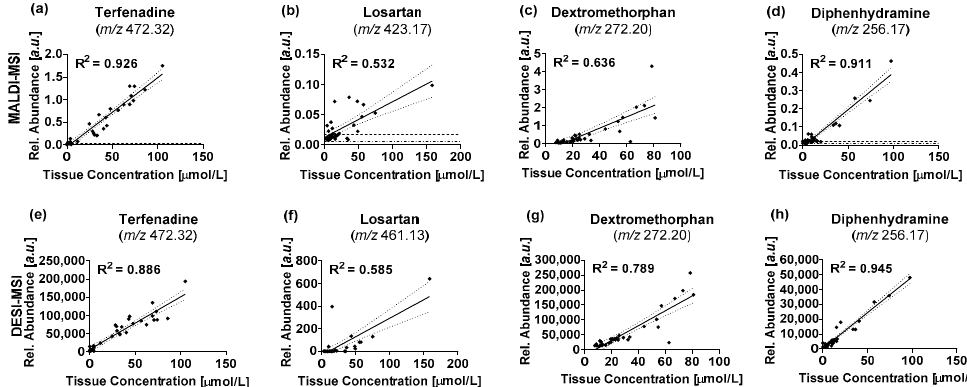
Figure 6. Comparison of drug tissue concentrations (terfenadine ( a , d ), losartan ( b , f ), dextromethorphan ( c , g ), diphenhydramine ( d , h )) determined by LC-MS/MS and MALDI-MSI ( a – d ) and DESI-MSI ( e – h ), respectively. Each datapoint describes the measured data for one of the three intestinal segments that were analyzed for each animal. Relative abundances for MSI data are represented by the mean abundance of the whole tissue section. — Indicate best-fit linear regression lines … indicate the 95% confidence interval of the regression lines -·-indicate the LOD for the respective MSI technique --- indicate the LLOQ for the respective imaging technique.